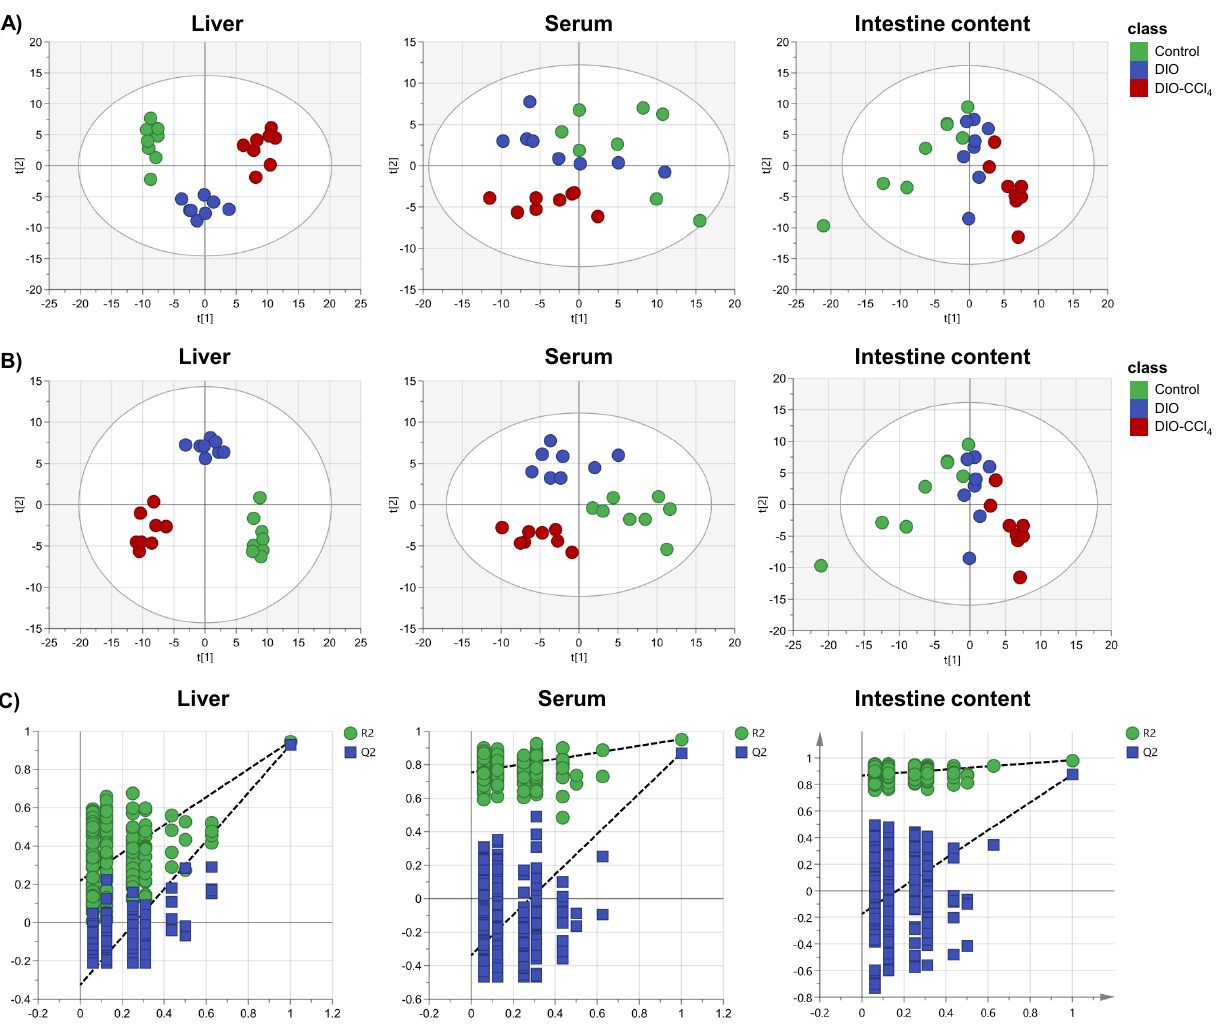
Figure 2. The metabolomic analysis of liver, serum and intestine content. ( A ) PCA score plots of liver, serum and intestine content. ( B ) PLS-DA score plots of liver, serum and intestine content. ( C ) Model validation using a permutation test with 200 cycles of liver, serum and intestine